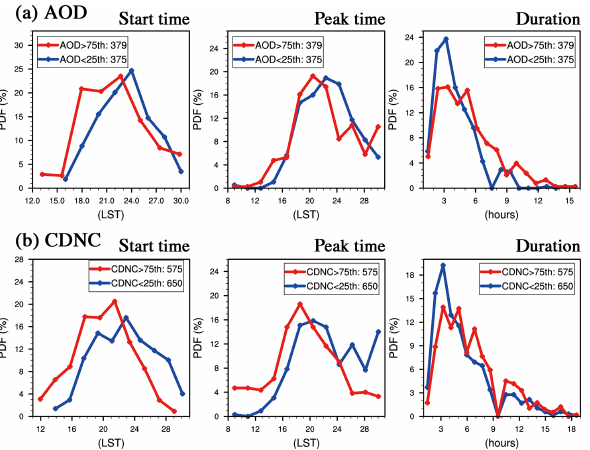
Figure 8. PDFs of start time (units: LST), peak time (units: LST), and duration (units: hours) of heavy rainfall on selected clean (blue lines) and polluted (red lines) conditions with SH at 850hPa (from ERA-Interim) less than the 75th percentile, respectively, using in- dicators of (a) AOD and (b) CDNC (cm − 3 ), during early summers from 2002 to